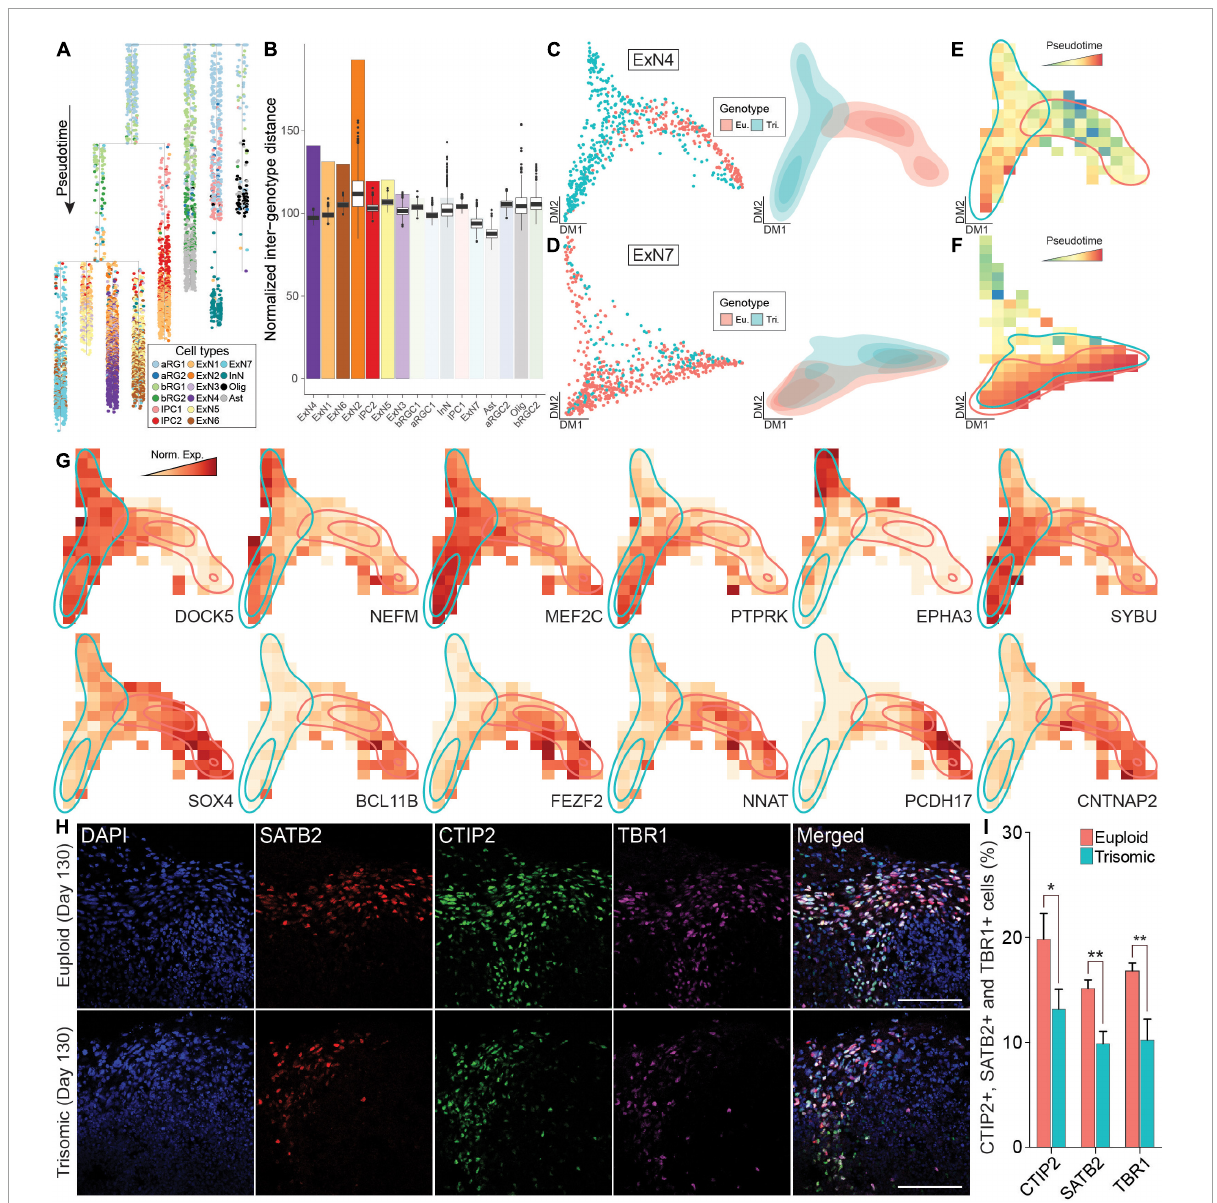
FIGURE4 Pseudotime analysis of scRNA-seq data from euploid and trisomic cortical spheroids (CS) at day 130 . (A) Dendrogram showing single cells along pseudotime. Branches on dendrogram signify divergence in transcriptome profiles. Colors represent cell types. (B) Bar graph showing observed normalized inter-genotype distance (IGD) in each cell type. Box plots on top of each observed IGD show estimated IGDs from 1,000 permutations. Cell types are arranged by statistical significance of observed IGC. The first six cell types on the graph are statistically significant ( p -value < 0.001). (C) Diffusion map (left panel) showing single cells and density plot (right) showing the distribution of single cells from ExN4 cell type. Colors represent genotype (eu., euploid, red; tri., trisomic, blue). (D) Diffusion map (left panel) showing single cells and density plot (right) reflecting the distribution of single cells from ExN7 cell type. Colors represent genotype (euploid, red; trisomic, blue). (E) Raster plot showing pseudotime in diffusion map space of ExN4 as in panel (C) . Colors represent pseudotime. Regions with high density of euploid (red) or trisomic (blue) cells are outlined. (F) Raster plot showing pseudotime in diffusion map space of ExN7 as in panel (D) . Heatmap colors represent pseudotime. Regions with high density of euploid (red) or trisomic (blue) cells are outlined. (G) Raster plot showing expression levels in diffusion map space as in panel (C) of genes specifically associated with trisomic or euploid cells in ExN4. Heatmap colors represent normalized gene expression levels (norm. exp.). Regions with high density of euploid (red) or trisomic (blue) cells are outlined. (H) IHC staining with anti- SATB2, anti-CTIP2, and anti-TBR1 antibodies in euploid and trisomic CS on day 130. (I) Bar graph showing the percentage of cells expressing CTIP2, SATB2 or TBR1 IHC signal calculated by quantifying the ratio of number of CTIP2+, SATB2+, or TBR1+ over total number of cells stained with DAPI and multiplied by 100%. The quantification is performed using ACEq application and analyzed using student t -test (euploid, n = 16; trisomic, n = 15). Error bar represents standard error. * p < 0.05; ** p < 0.01. The quantification results are generated from three independent differentiation experiments; Scale bar, 100 µ